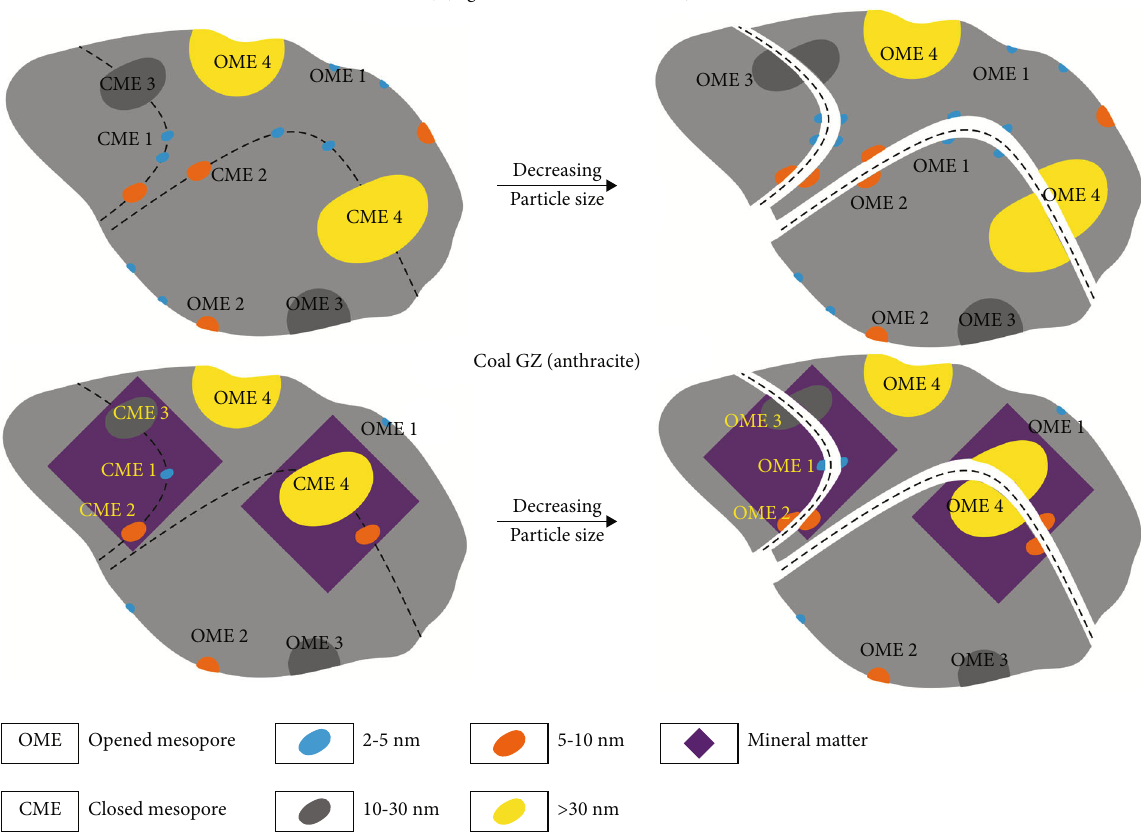
Figure 12: Evolution model of mesopore structure during the crushing process of Coal XJ and Coal